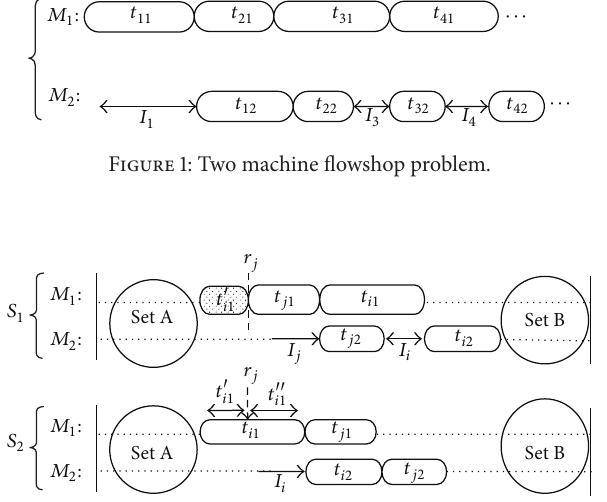
Figure2:Schedules 𝑆 1 and 𝑆 2 atarrivalofjob 𝑗 inpreemption-repeat